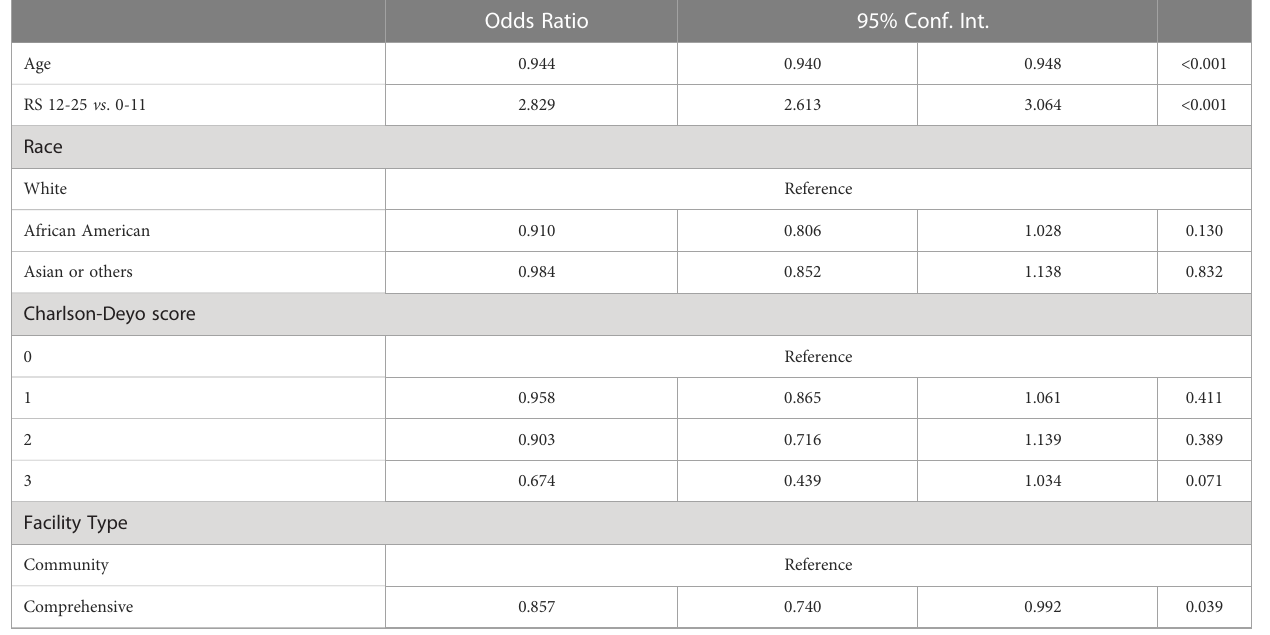
TABLE 2 Multivariable logistic regressions for predictors of receipt of chemotherapy in pathological stage I-III HR+HER2- breast cancer patients with 1 – 3 positive nodes, NCDB 2004-2018. Odds Ratio 95% Conf.